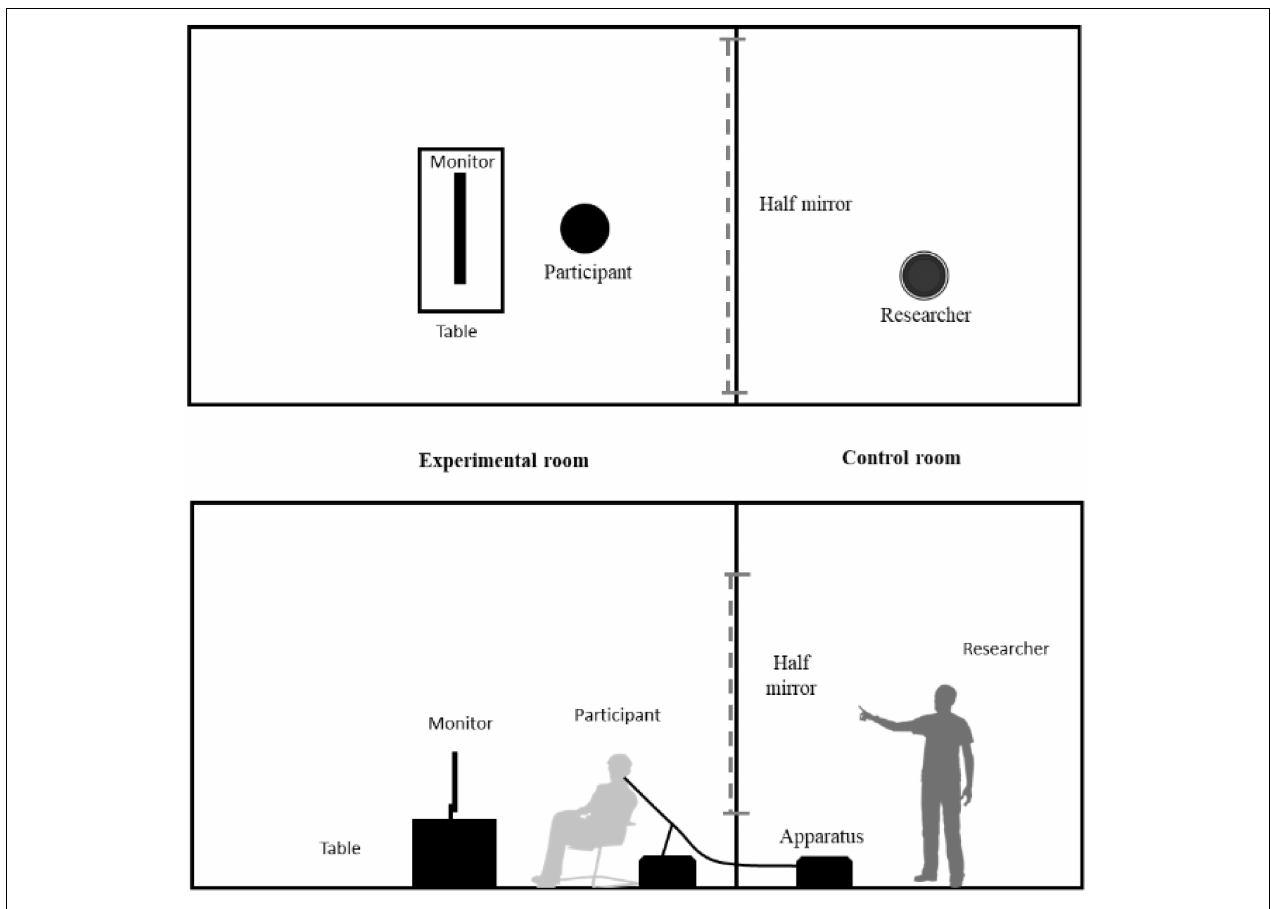
FIGURE 3 | Experimental room